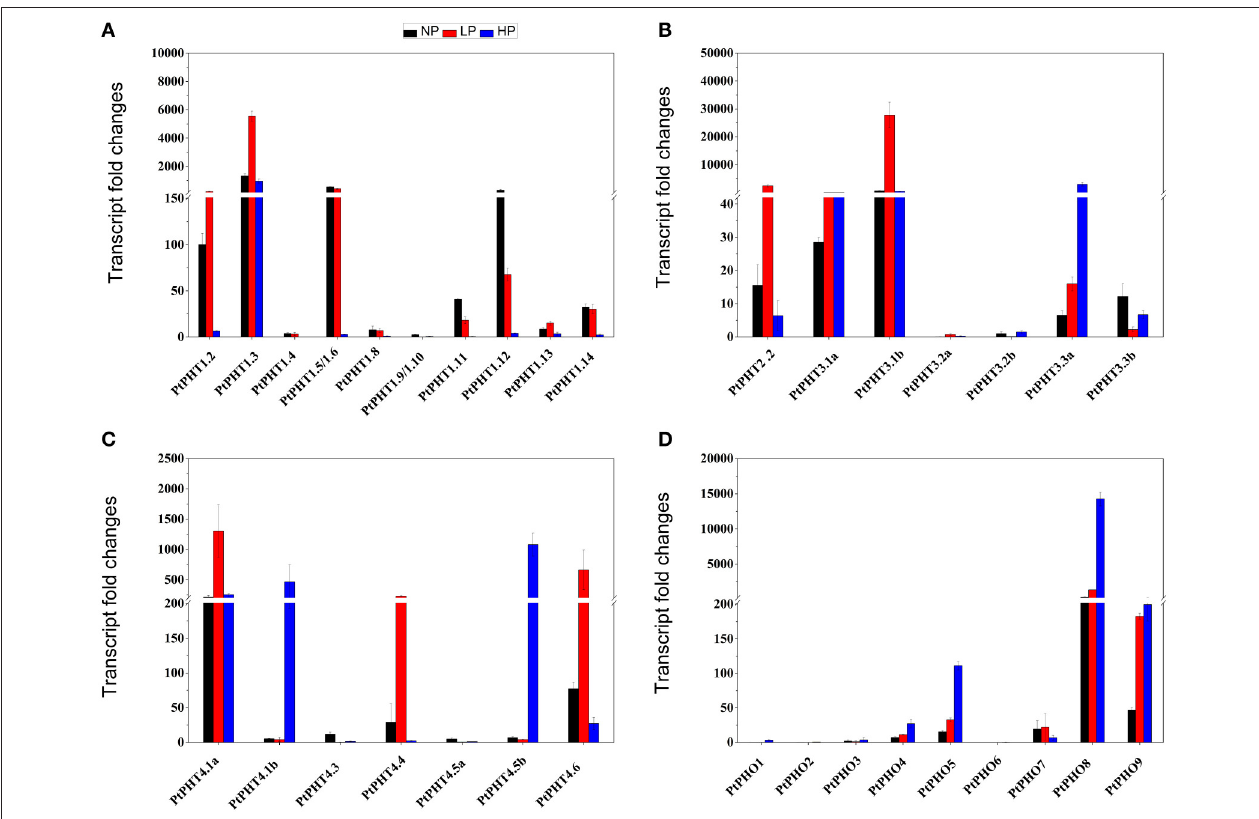
FIGURE 6 | The expression of PtPHT genes (A: PHT1; B: PHT2 and PHT3; C: PHT4; D: PHO) under different phosphate levels in roots of P. simonii seedlings. The relative expression of PHT1.2 was set as a standard (100). Total RNA was isolated using a plant RNA extraction kit (R6827, Omega Bio-Tek, GA, USA) according to the manufacturer’s instructions. The RNA was used for qRT-PCR with PHT -specific primers. The signal intensities were calibrated based on a constitutively expressed poplar actin gene (Brunner et al., 2004b). The data are presented as the mean ± SD of three separate